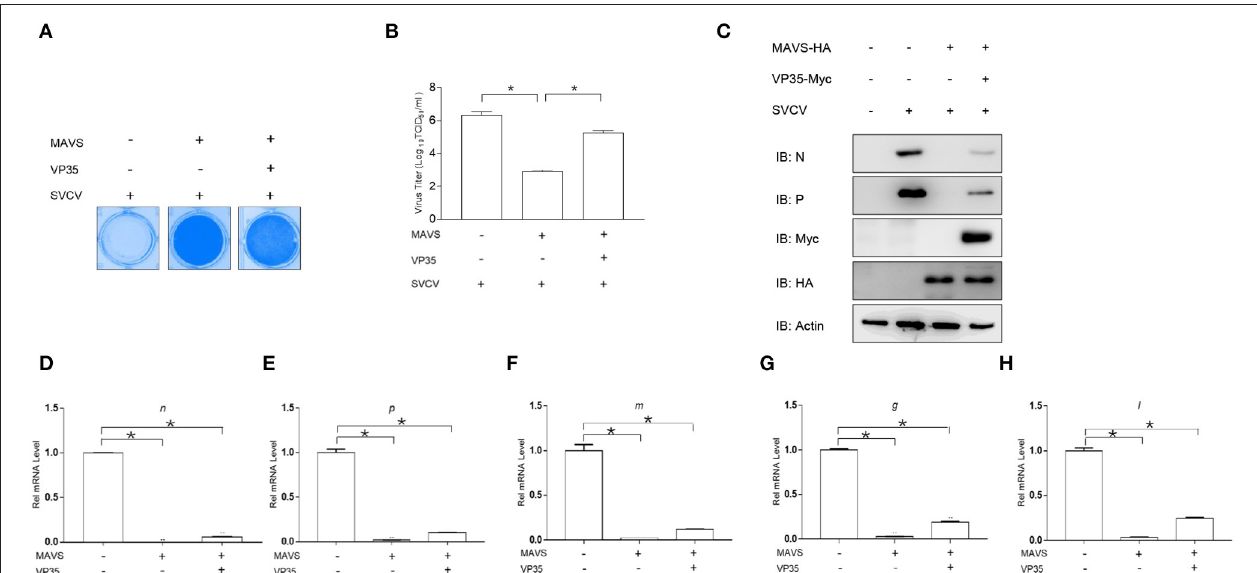
FIGURE 6 | VP35 blocks MAVS-induced cellular antiviral immune response. (A) EPC cells seeded in 24-well plates overnight were transfected with 0.5 µ g of MAVS-HA and 0.5 µ g VP35-pcDNA3.1( + ) or pcDNA3.1( + ). At 24h post-transfection, cells were infected with SVCV (MOI = 0.001) for 48h. Then, cells were fixed with 4% paraformaldehyde (PFA) and stained with 1% crystal violet. (B) Culture supernatants from the cells infected with SVCV were collected, and the viral titer was measured according to the method of Reed and Muench. (C) EPC was seeded in six-well plates and transfected with 2 µ g of MAVS-HA and 2 µ g of VP35-Myc or empty vector. At 24h post-transfection, cells were infected with SVCV (MOI = 1). After 24-h infection, the WCLs were detected by IB with the anti-N, anti-P, anti-Myc, anti-HA, and anti- β -actin Abs, respectively. (D–H) The same samples were prepared similarly as described above for (C) . Total RNAs were extracted to examine the mRNA levels of cellular n, p , m , g , and l . The relative transcriptional levels were normalized to the transcriptional level of the β -actin gene and were represented as fold induction relative to the transcriptional level in the control cells, which was set to 1. Data are expressed as mean ± SEM, n = 3. Asterisks indicate significant differences from control values (* p < 0.05).